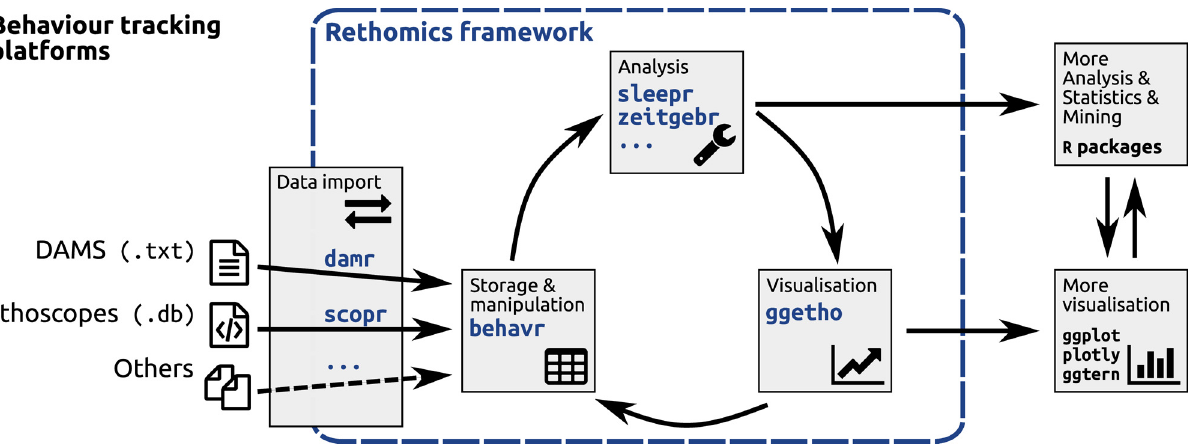
Fig 1. The rethomics workflow. Diagram representing the interplay between, from left to right, the raw data, the rethomics packages (in blue) and the rest of the R ecosystem.